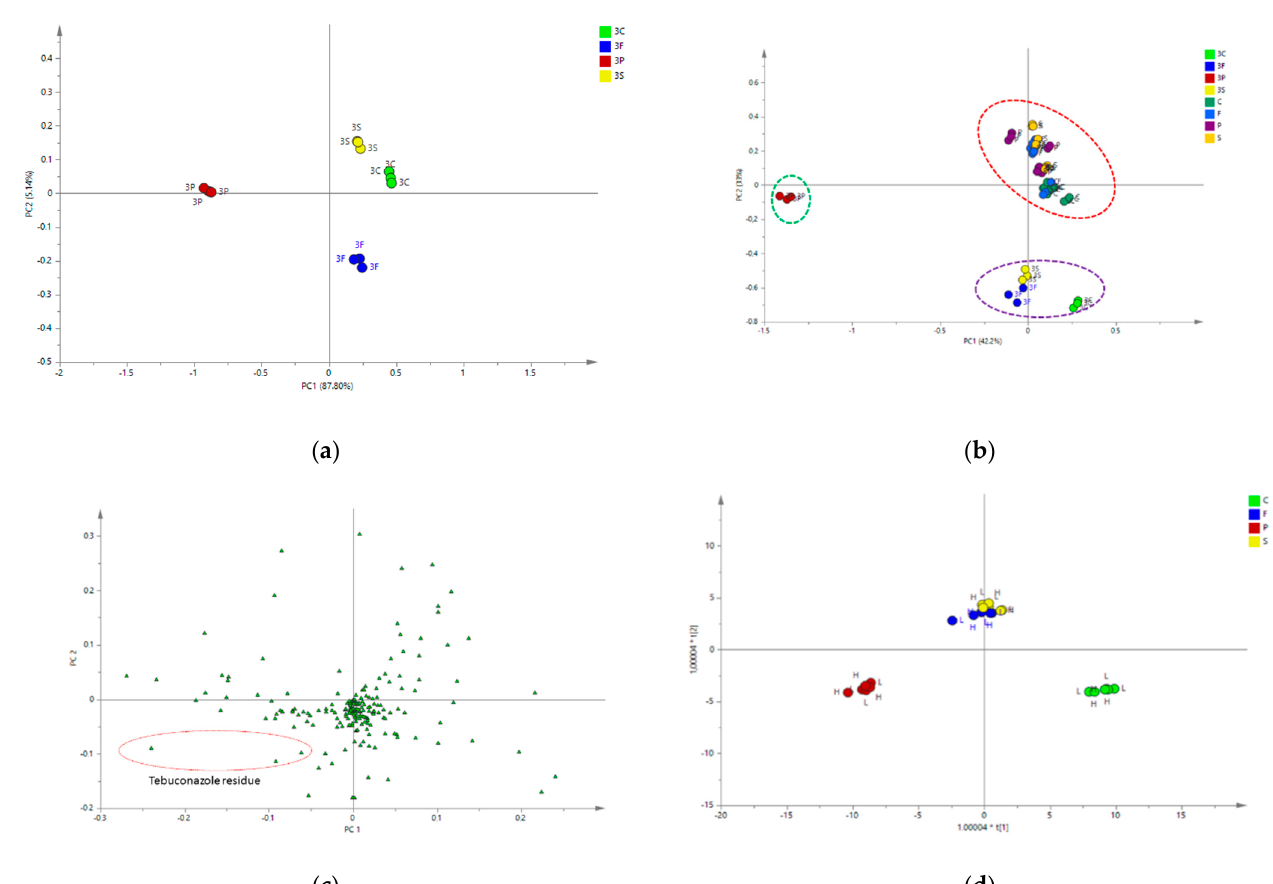
Figure 6. ( a ) Score scatter plot showing result of the PCA with all of the seedling samples treated with 0.03% fungicides. ( b ) Score scatter plot of all treated seedlings: 0.03% Pronto Plus, 0.03% Folicur, and 0.03% Switch; 0.001% Pronto Plus and 0.001% Folicur; 0.005% Switch. ( c ) Loadings scatter plot of all treated seedlings in b. ( d ) Score scatter plot of OPLS-DA with low and high concentration of fungicides at 7 days after harvesting. The numbers correspond to harvesting time (7, 14, 21, and 28 days after treatment) and the letters to fungicides (P—Pronto Plus, F—Folicur, and S—Switch) and control—C.